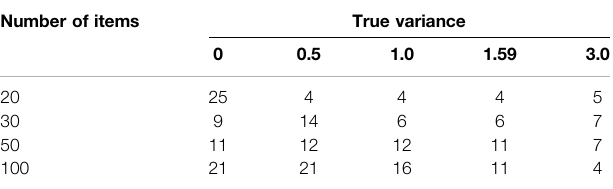
Note. The number of comparisons per item represents the average number of comparisons per item in a set of items (i.e., one item may be compared more often than another item) rounded up to integers.